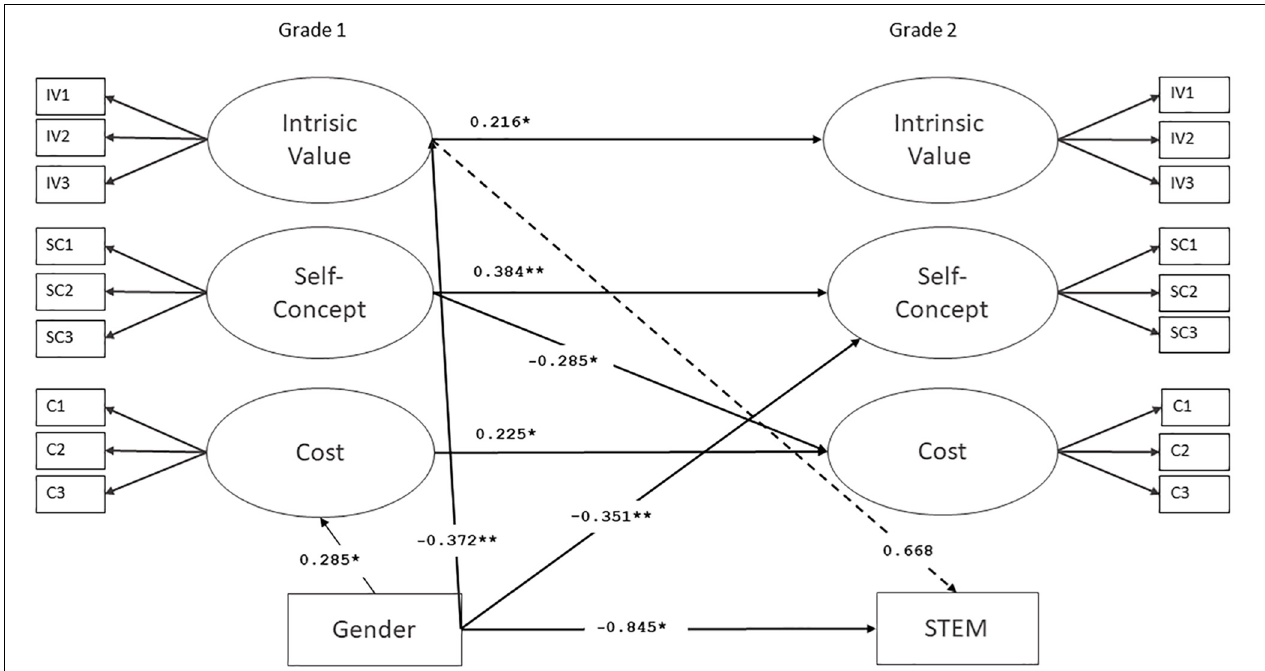
FIGURE 1 | Cross-lagged panel model for students’ task motivation and occupational aspirations. IV, intrinsic value; SC, self-concept; C, cost. ∗ p < 0.015, ∗∗ p < 0.01, ∗∗∗ p <